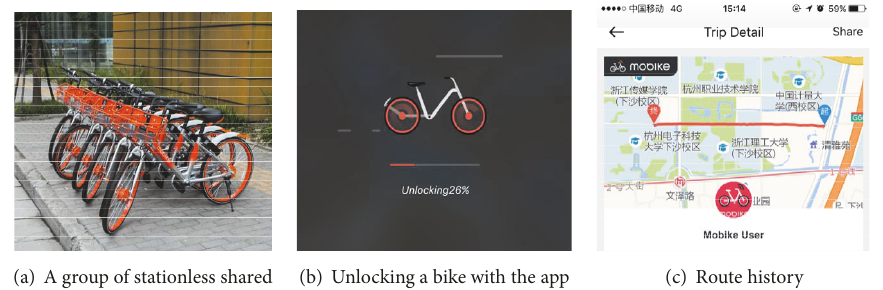
Figure 1: Stationless bike-sharing.